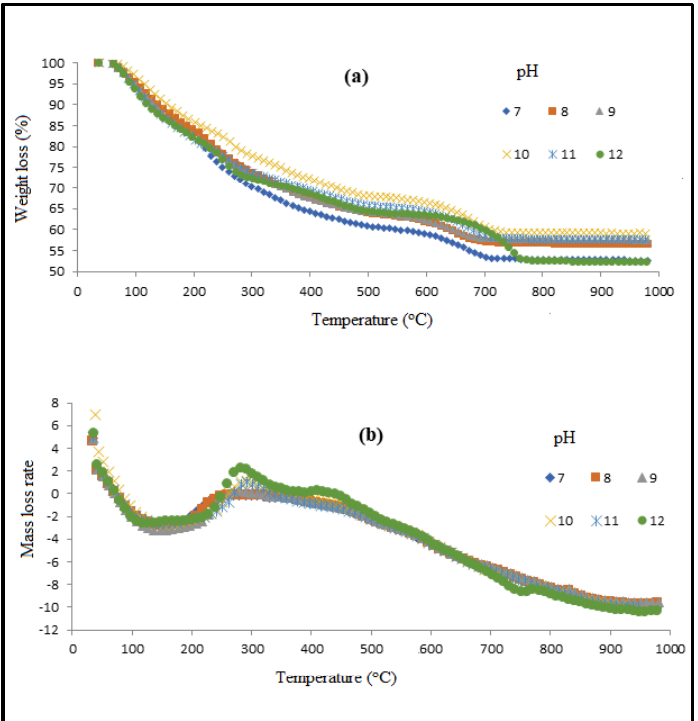
Figure 2. Thermal analysis curves ( a ) TGA and ( b ) SDTA PPVA-AlPO 4 nanocomposites samples with different pH. Table 2. Thermal properties of SDTA and TGA for PPVA-AlPO 4 nanocomposite for various pH.